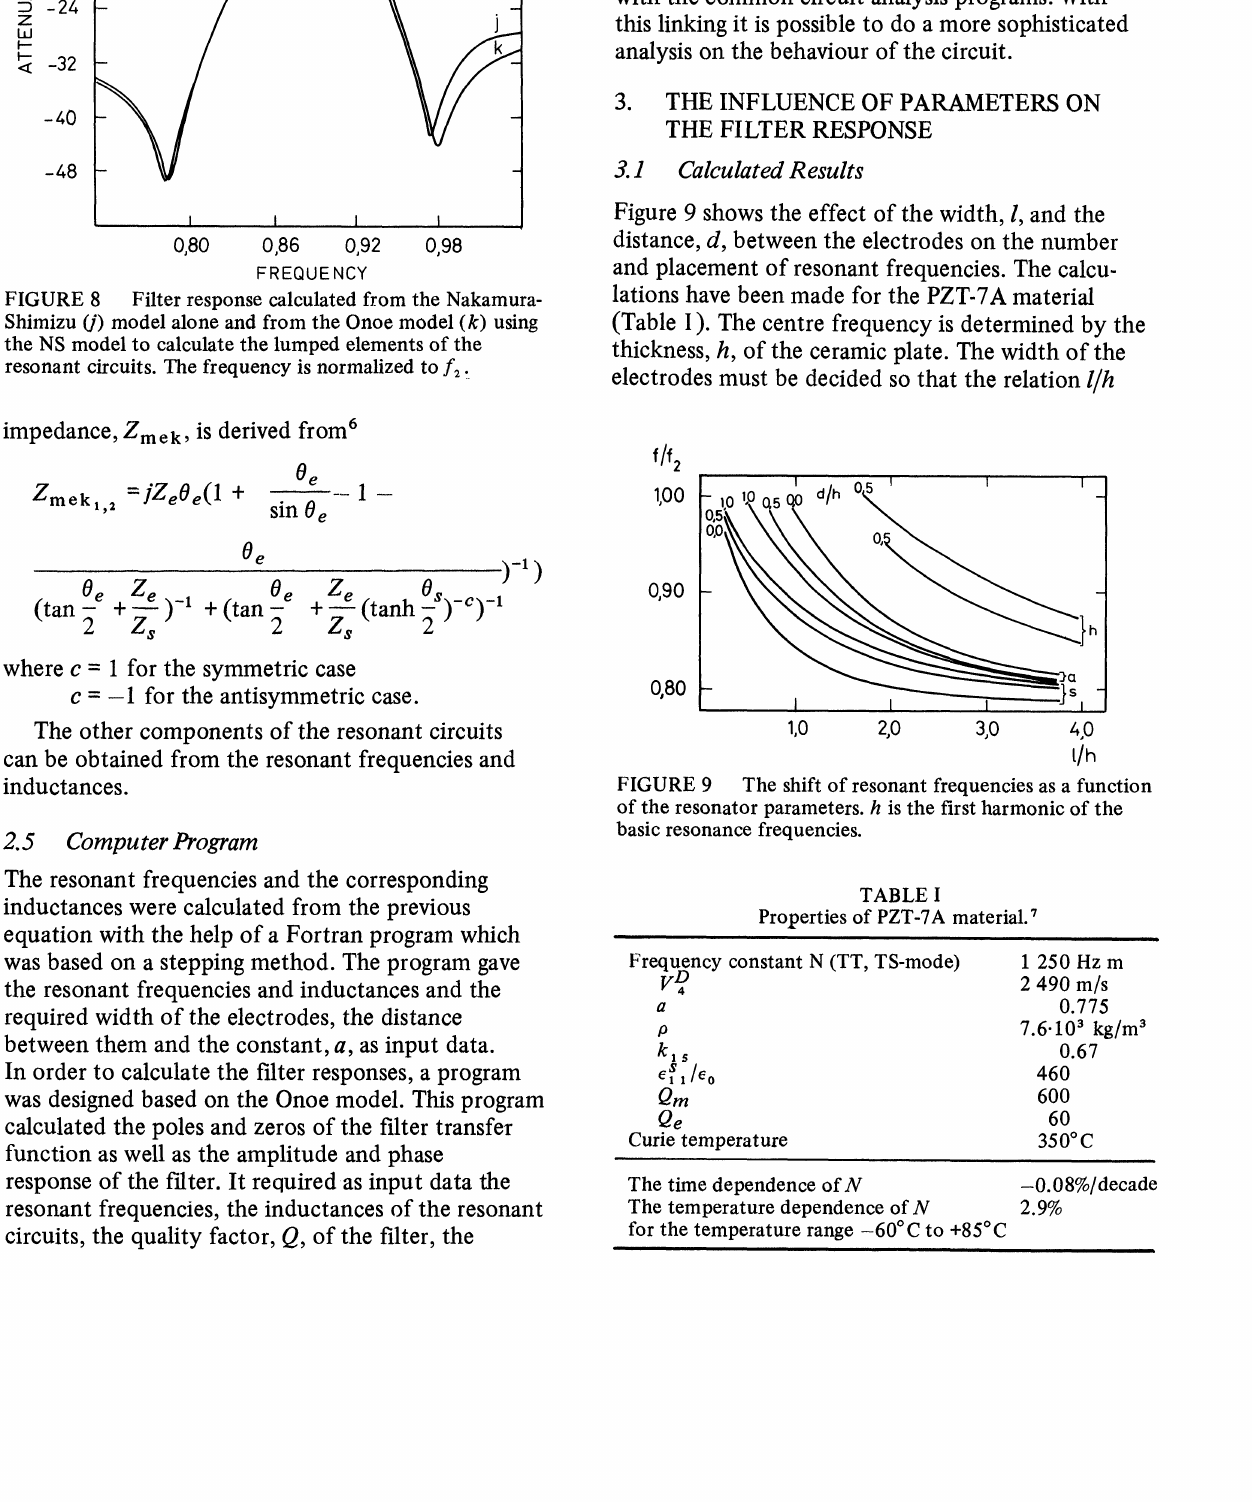
Filter response calculated from the Nakamura- Shimizu (/) model alone and from the Onoe model (k) using the NS model to calculate the lumped elements of the resonant circuits. The frequency is normalized to f